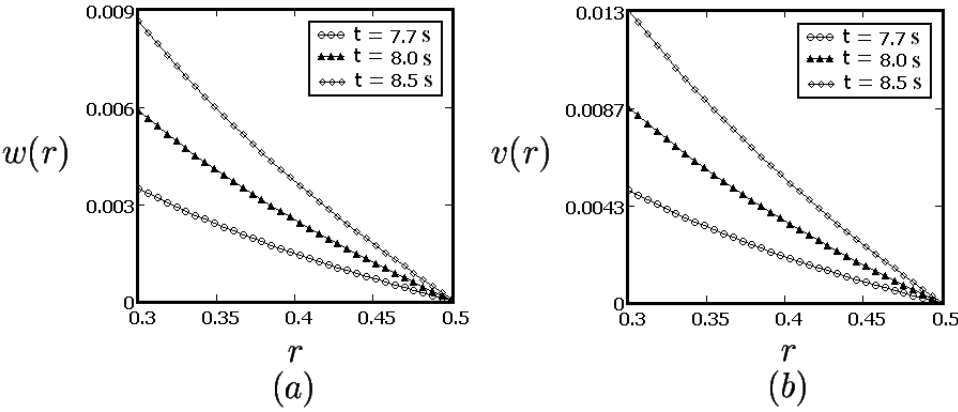
Fig. 5. Profiles of the velocity components w ( r , t ) and v ( r , t ) given by Eqs. (39), for R 1 = 0.3, R 2 = 0.5, f = g = −2, ω 1 = ω 2 = 1, ν = 0.1188, µ = 10.384, α = 0.2 and different values of t